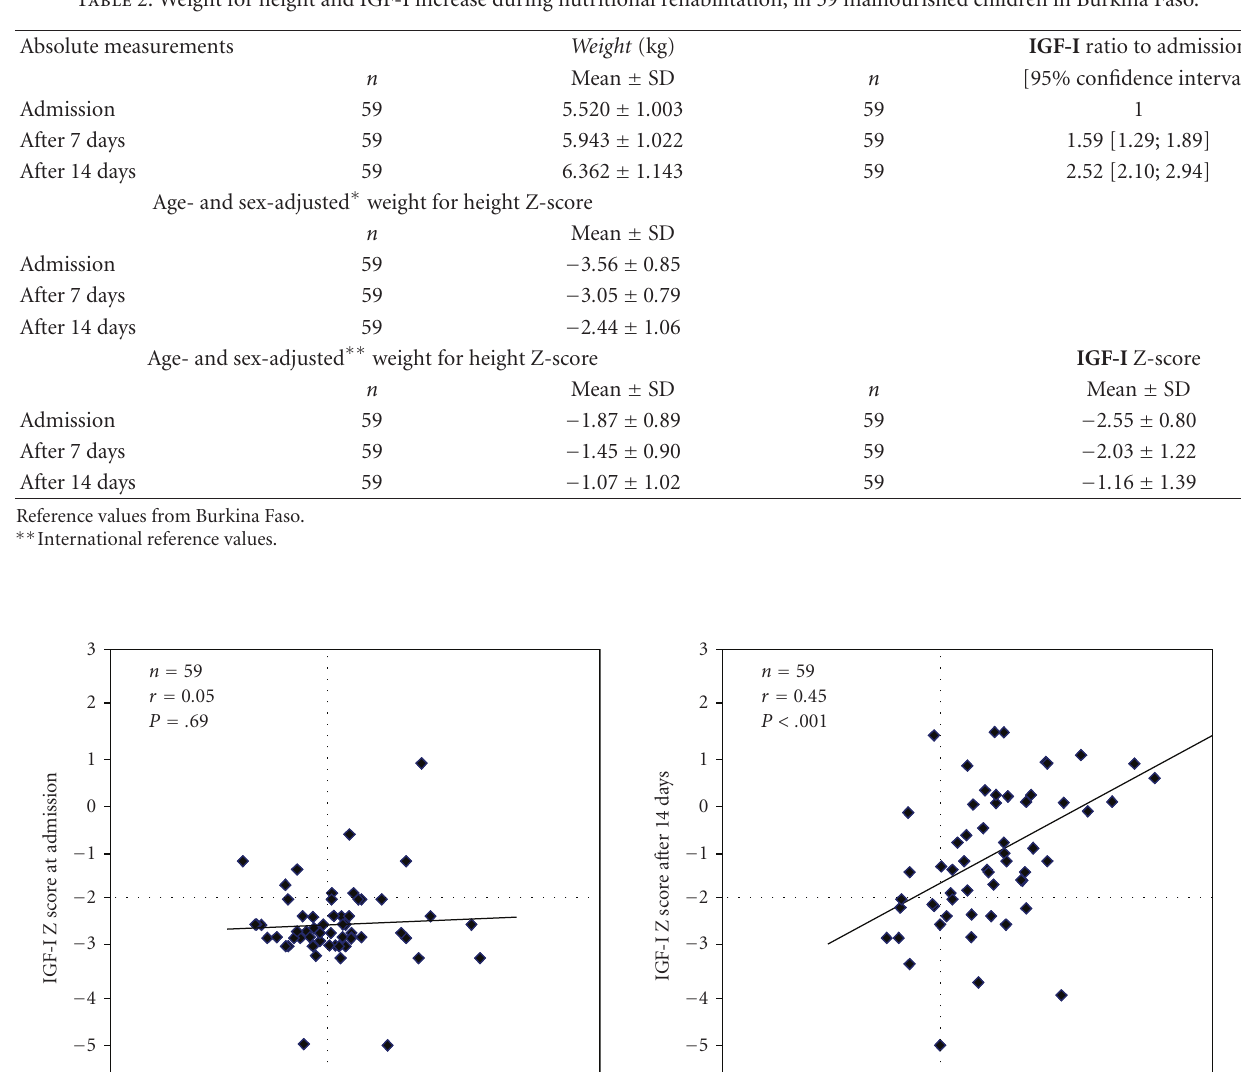
Table 2: Weight for height and IGF-I increase during nutritional rehabilitation, in 59 malnourished children in Burkina Faso.